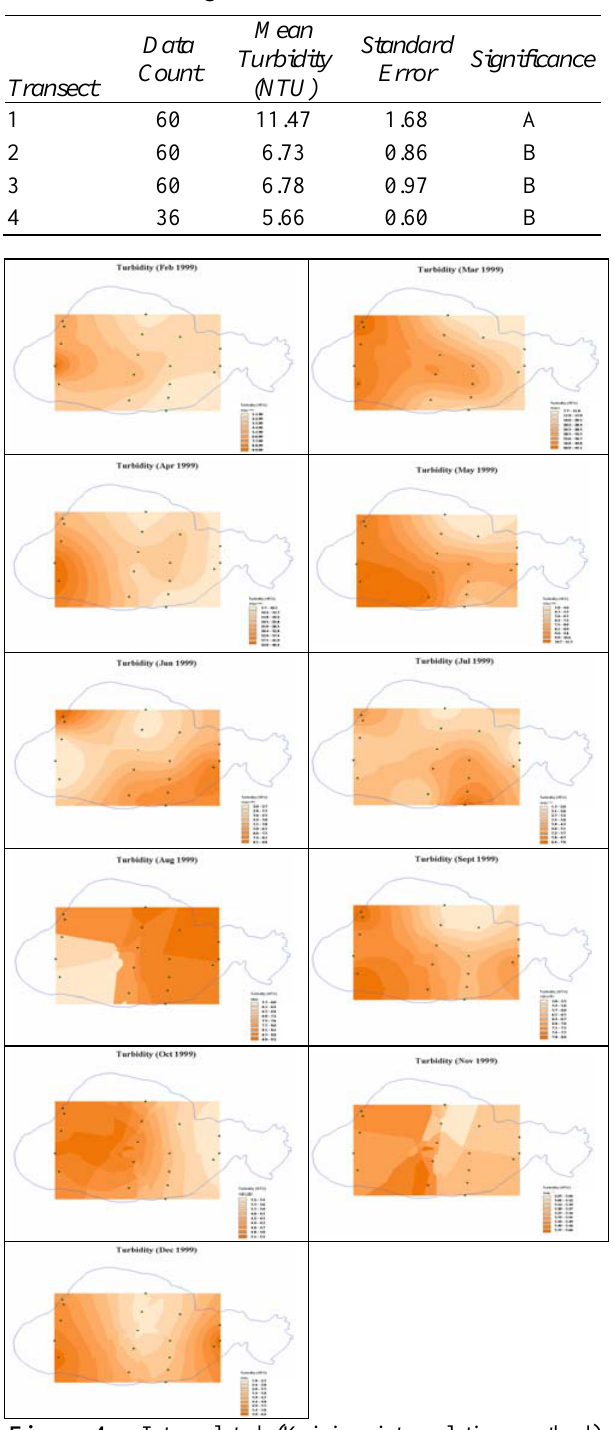
Table 4: One-way Analysis of Variance comparing turbidity (NTU) measured monthly at 18 sites in Lake Pontchartrain between January 1999 and December 1999. Transect 1 includes sites 1-5, transect 2 for sites 6-10, transect 3 for sites 11-15 and transect 4 comprises sites 15-18. For the expression of significance by One-way ANOVA, different letters indicate the significant difference at a P value of 0.05.